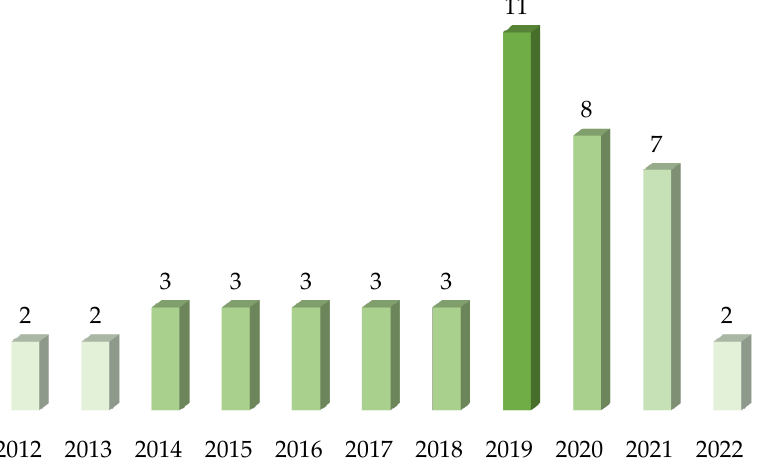
Figure 3. Evolution of the research literature review .